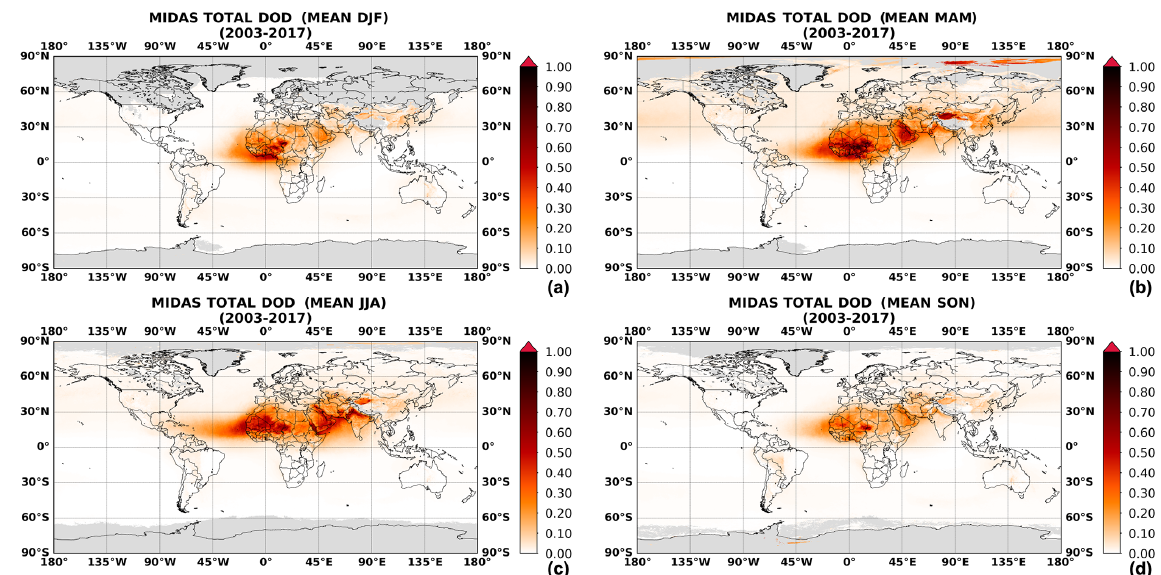
Figure 9. As in Fig. 8a but for (a) December–January–February (DJF), (b) March–April–May (MAM), (c) June–July–August (JJA), and (d) September–October–November